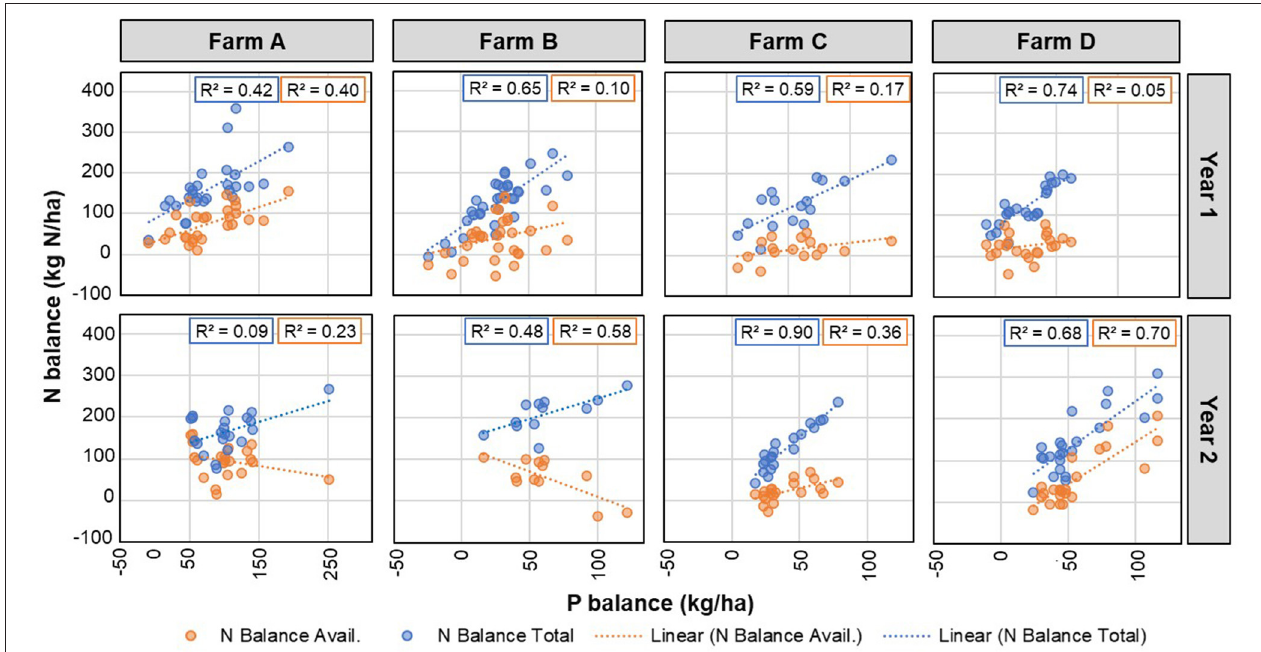
FIGURE 4 | Nitrogen (N) vs. phosphorus (P) balances for corn fields of four farms in northern New York (A-D) for 2 years.